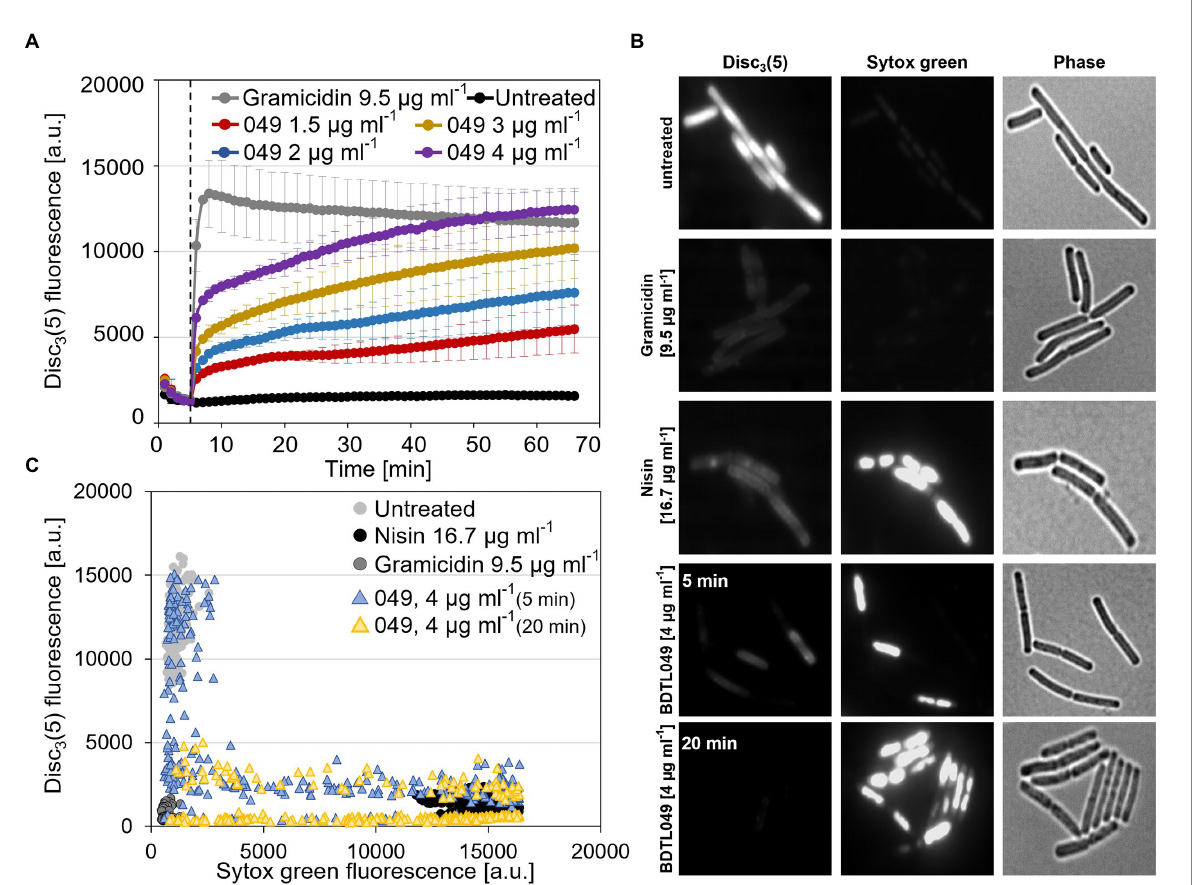
FIGURE 4 BDTL049 depolarizes the membrane and leads to pore formation. (A) Plate reader bulk measurement using the voltage-sensitive dye Disc 3 (5), showing membrane depolarization effects of wild type Bacillus subtilis cells upon treatment with different concentrations of the SynAnt BDTL049. The time point of compound addition is indicated by a dashed line. The peptide antibiotic Gramicidin as well as untreated cells are depicted and serve as controls. (B) Exemplary phase contrast (right panels) and fluorescence microscopy pictures of wild type B. subtilis cells stained with the voltage-sensitive dye Disc 3 (5) (left panels) and the DNA binding dye Sytox Green (middle panels) in the absence or presence of 4 μ g ml − 1 BDTL049. Incubation of cells with compounds was set to 5 min or as stated otherwise. As positive controls, cells were treated with 9.5 μ g ml − 1 (equivalent to 5 μ M) Gramicidin (depolarization without pore formation) or 16.7 μ g ml − 1 (equivalent to 5 μ M) Nisin (depolarization through pore formation). (C) Scatter plot showing fluorescence intensities of Disc 3 (5) and Sytox Green derived from individual cells ( n > 200). The data shown in graphs (A,C) derive from at least three independent biological